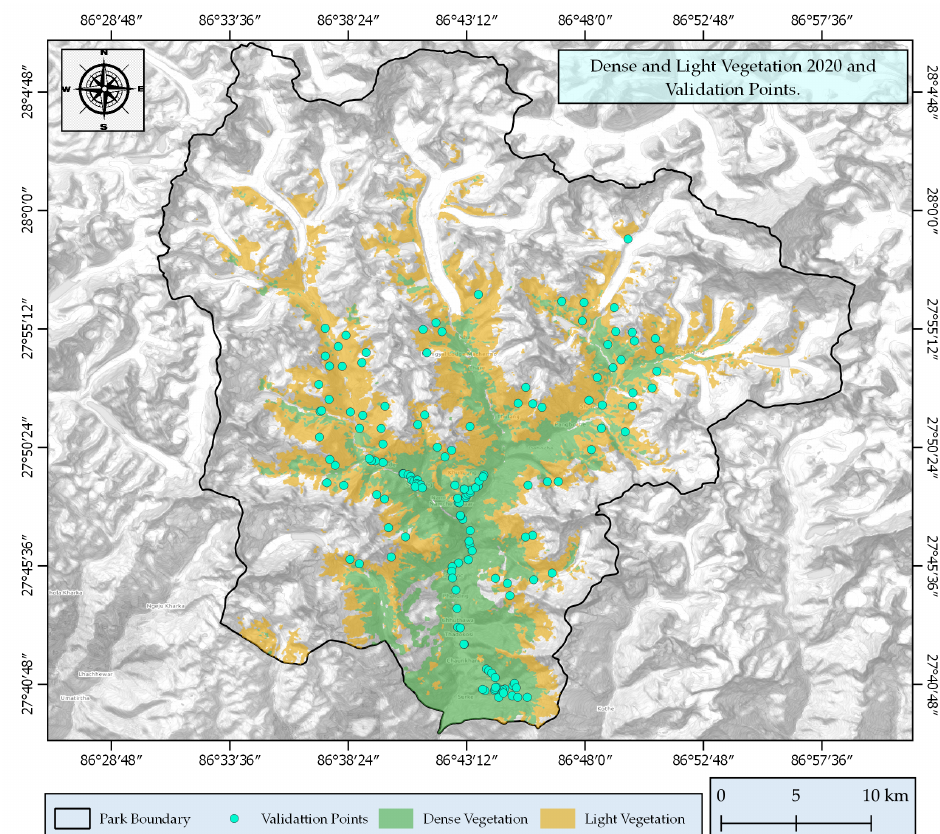
Figure 3. Validation points for dense vegetation and light vegetation for